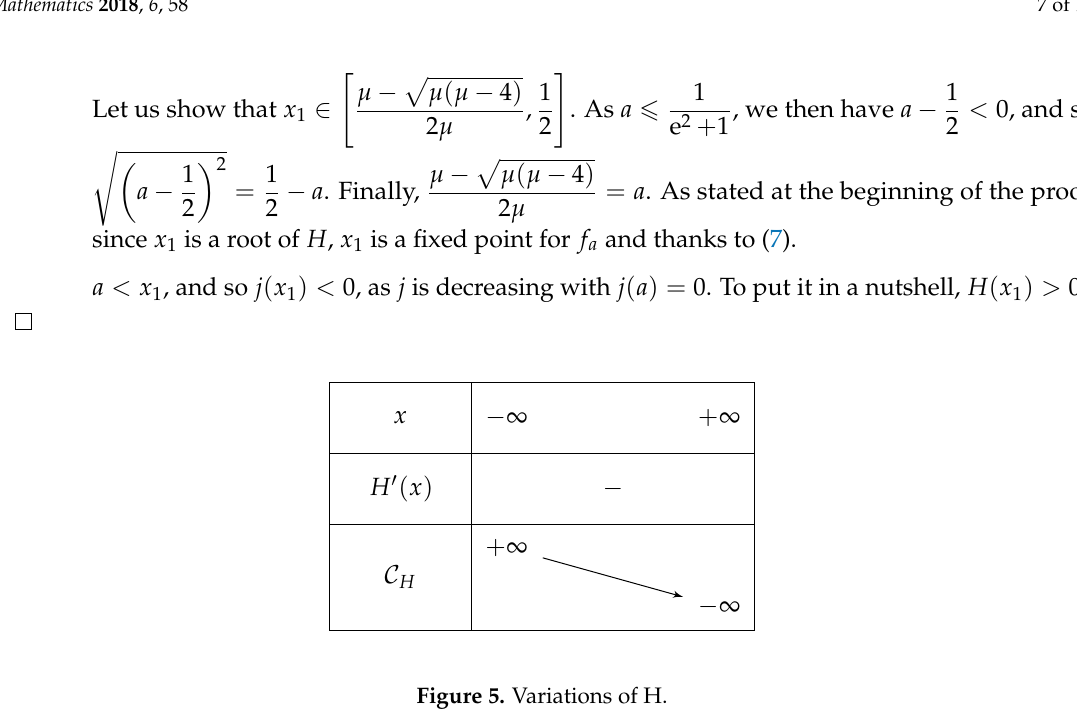
Figure 5. Variations of H.